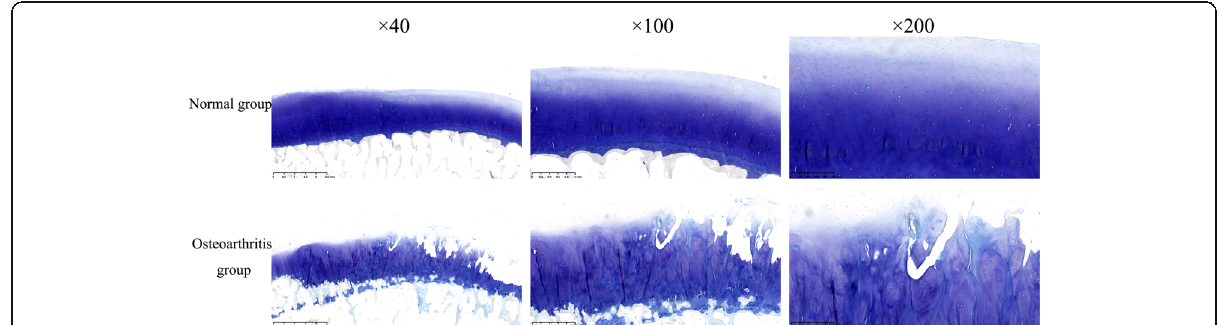
Fig. 2 The Toluidine blue staining of the cartilage in the normal group and the osteoarthritis